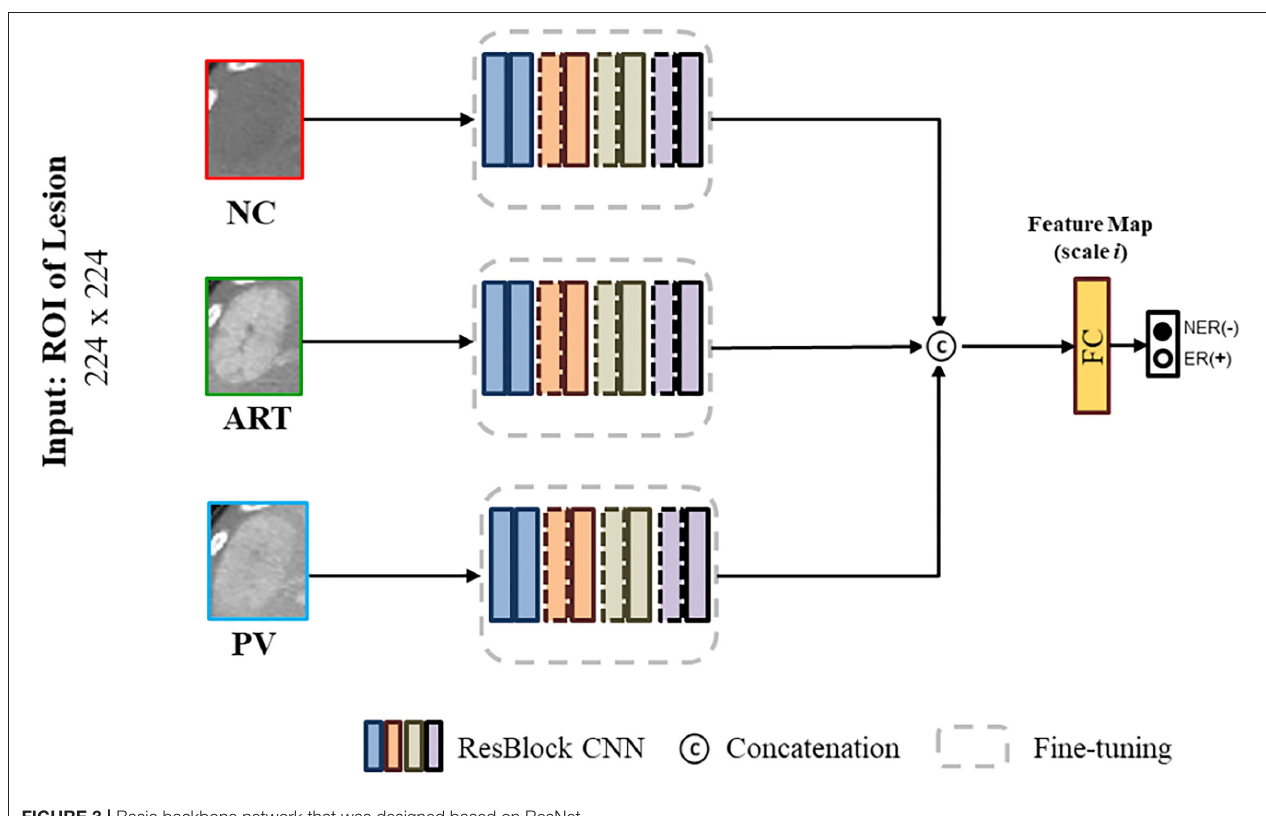
FIGURE 3 | Basic backbone network that was designed based on ResNet.